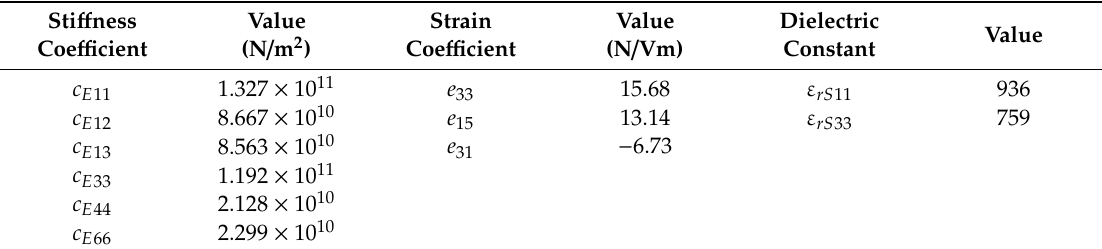
Table 2. The Coe ffi cient summary of the stress–charge form. Table 2. The Coefficient summary of the stress–charge form.